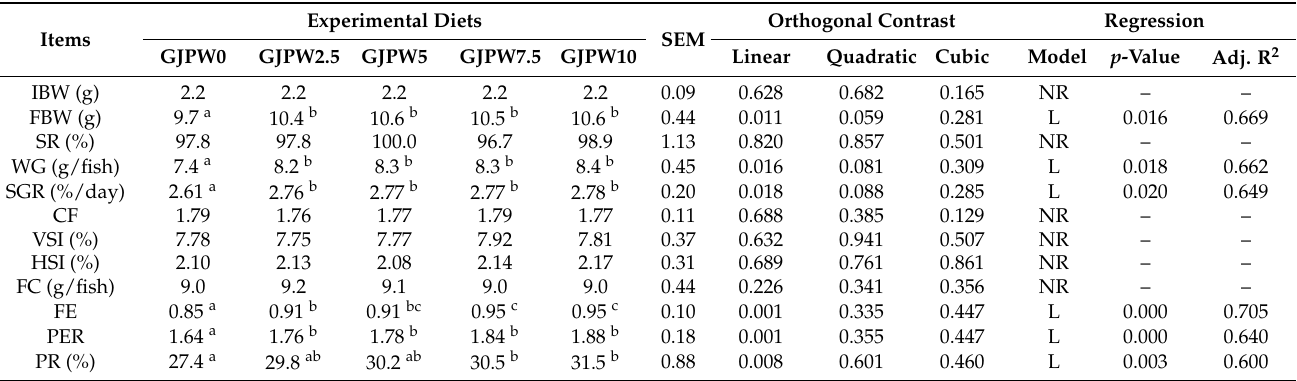
Table 4. Growth performance of juvenile rockfish fed with different levels of garlic juice processing waste (GJPW) inclusion in